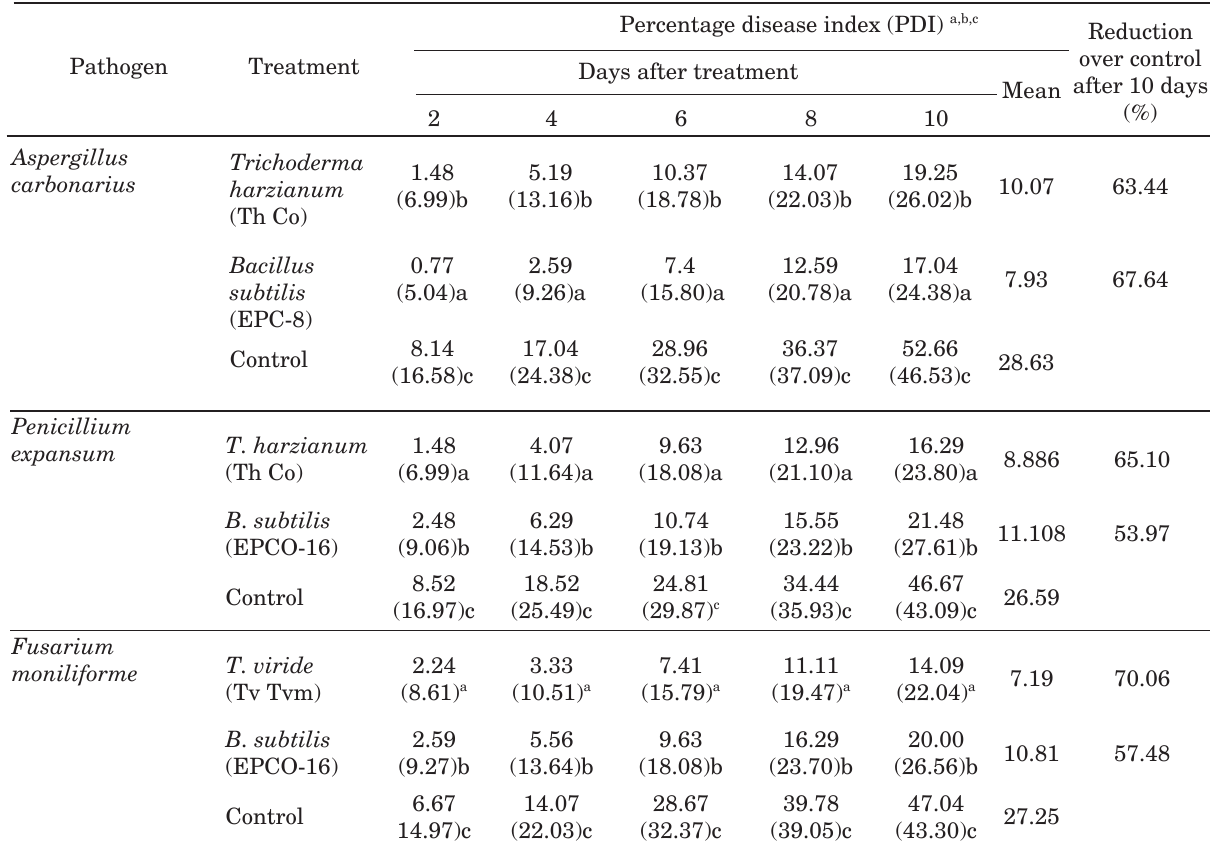
Table 3. Effect of combined inoculation of antagonists and pathogen on the incidence of postharvest rot disease in